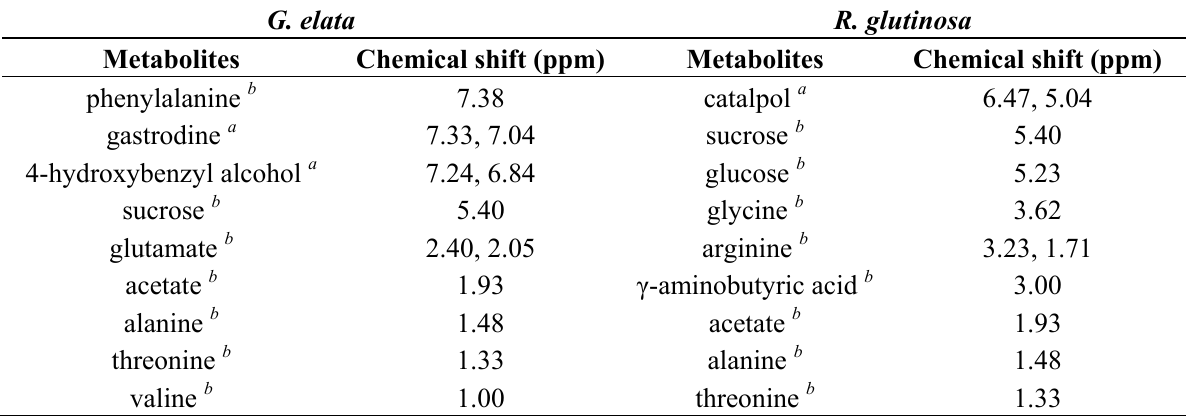
Table 1. Representative chemical shifts of metabolites putatively identified in G. elata and R. glutinosa using 1 H-NMR spectroscopy.